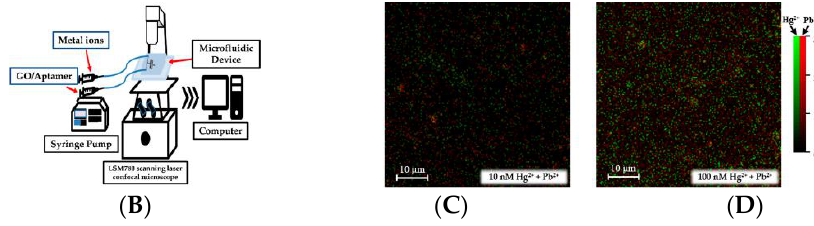
Figure 31. ( A ) experimental setup; ( B ) Schematic integration of experimental setup; ( C ) and ( D ) exemplary result of simultaneous detection of Hg 2+ and Pb 2+ ions in two concentrations, 10 nM and 100 nM respectively [118].